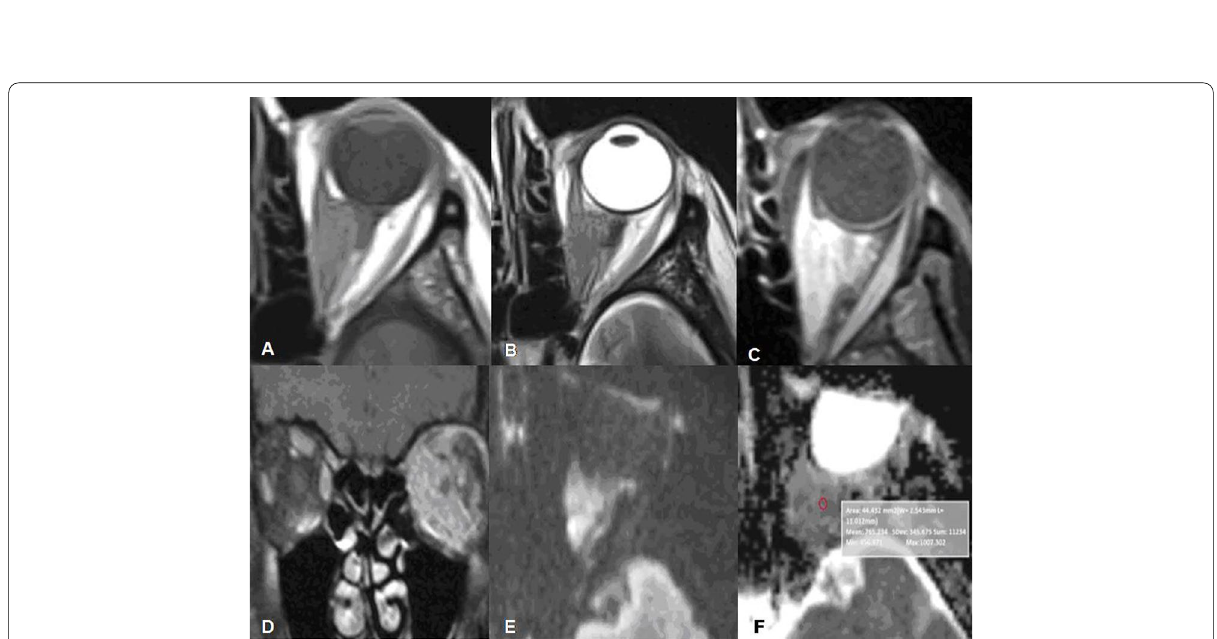
Fig. 7 A 56-year-old female patient with long history of left-sided dull aching orbital pain, chronic visual loss of left eye and limited left orbital movement. Axial T1 A shows T1 hypointense infiltrative retrobulbar mass involving the left medial rectus muscle, as well as the related extraconal and intraconal fat planes and encasing the optic nerve. Axial T2 image B shows ill-defined T2 hypointensity of the lesion. Axial and coronal T1 post-contrast images (C and D) reveal homogeneous enhancement of the mass lesion. Evident diffusion restriction on DWI (b 1000 )/ADC ( E , F ). The ADC value is 0.76 10 − 3 mm 2 /sec (F). Pathologically proved left-sided retrobulbar lymphoma (NHL) encasing the left optic ×